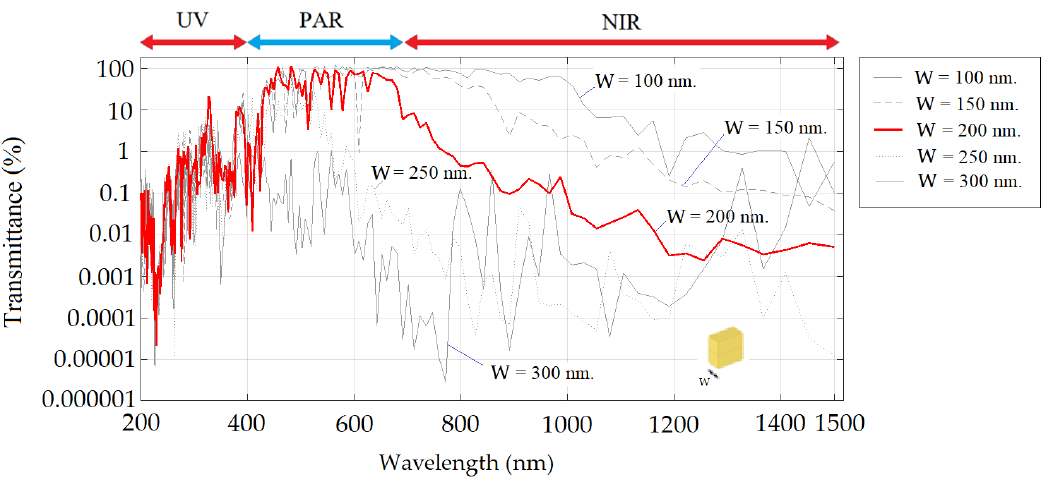
Figure 6. Transmittance when W is varied from 100 nm to 300